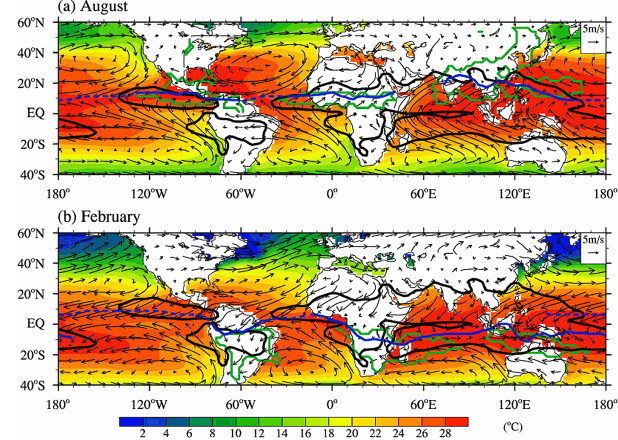
Figure 3. Climatological mean SST (shading) and 925hPa winds (vector) in (a) August and (b) February. The blue lines indicate the locations of the ITCZ (solid for monsoon trough and dashed for trade wind convergence). The tropical monsoon wind domains are outlined by the black lines, which are delineated by the annual re- versal of the zonal winds (westerlies in the local summer and east- erlies during the local winter). The monsoon precipitation domain is outlined by the green